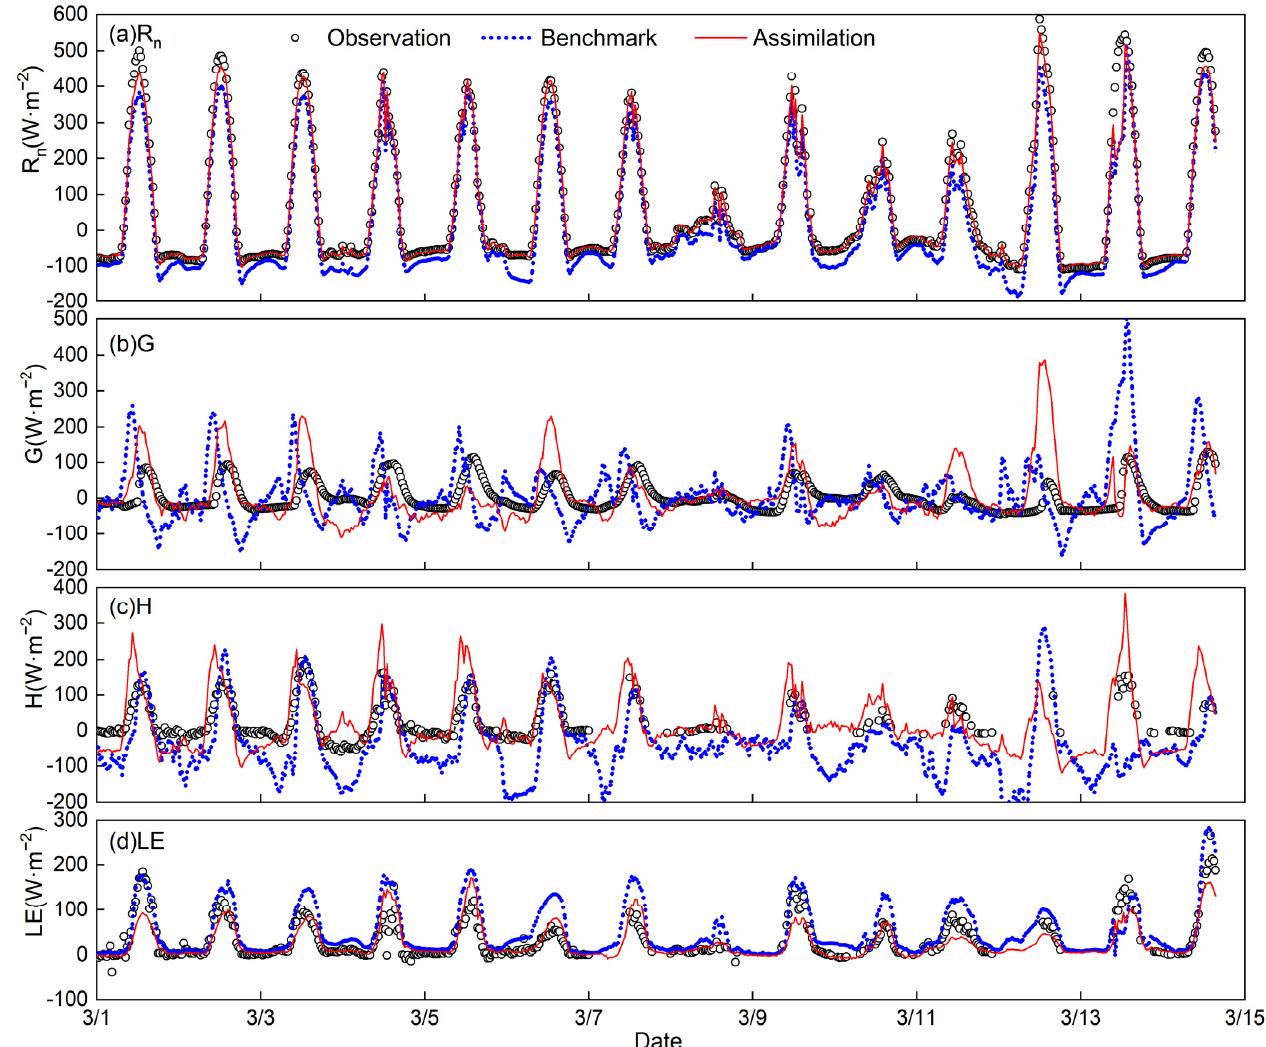
Figure 9. Comparison of surface flux assimilation results and benchmark run with ground measurements during wheat growing season from 1 March 2006 to 14 March 2006.